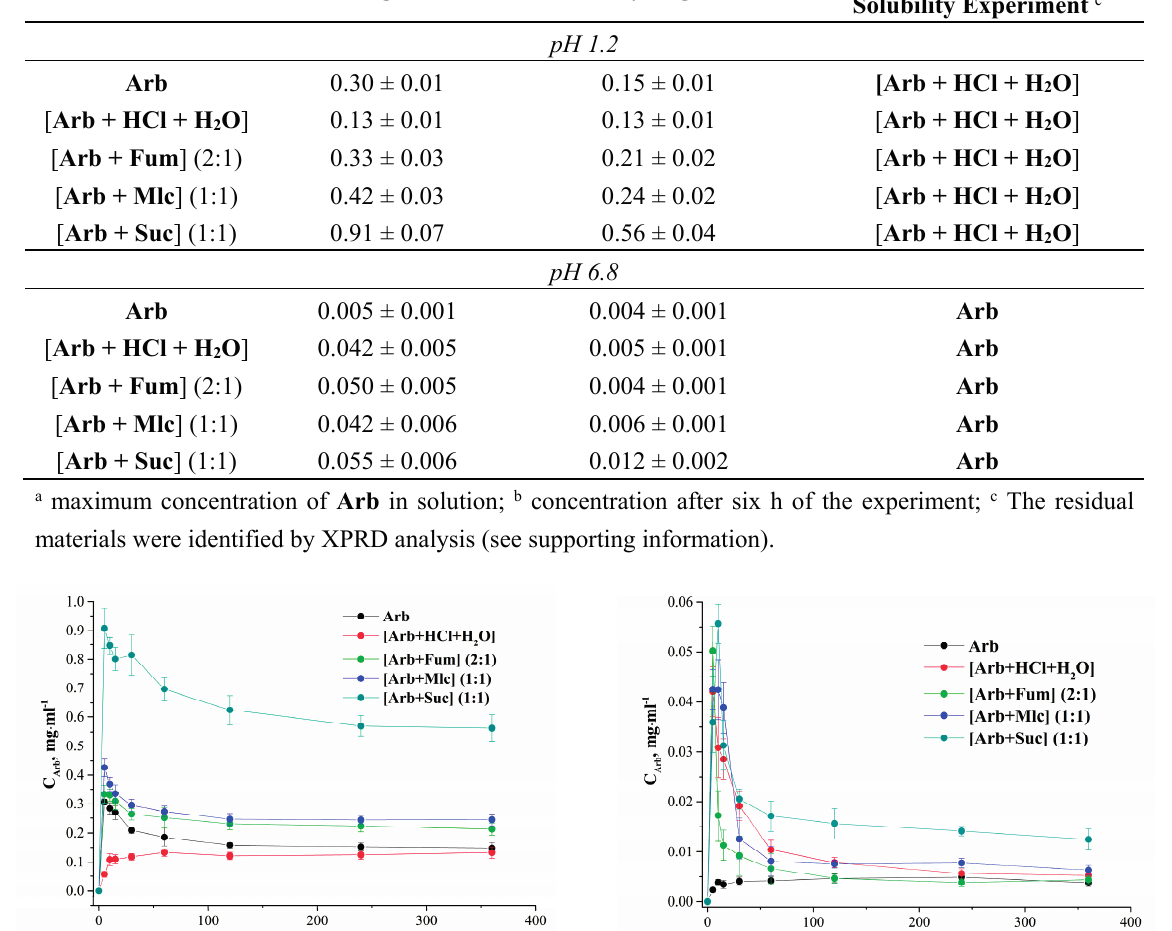
Solid Phase Recovered after Solubility Experiment c